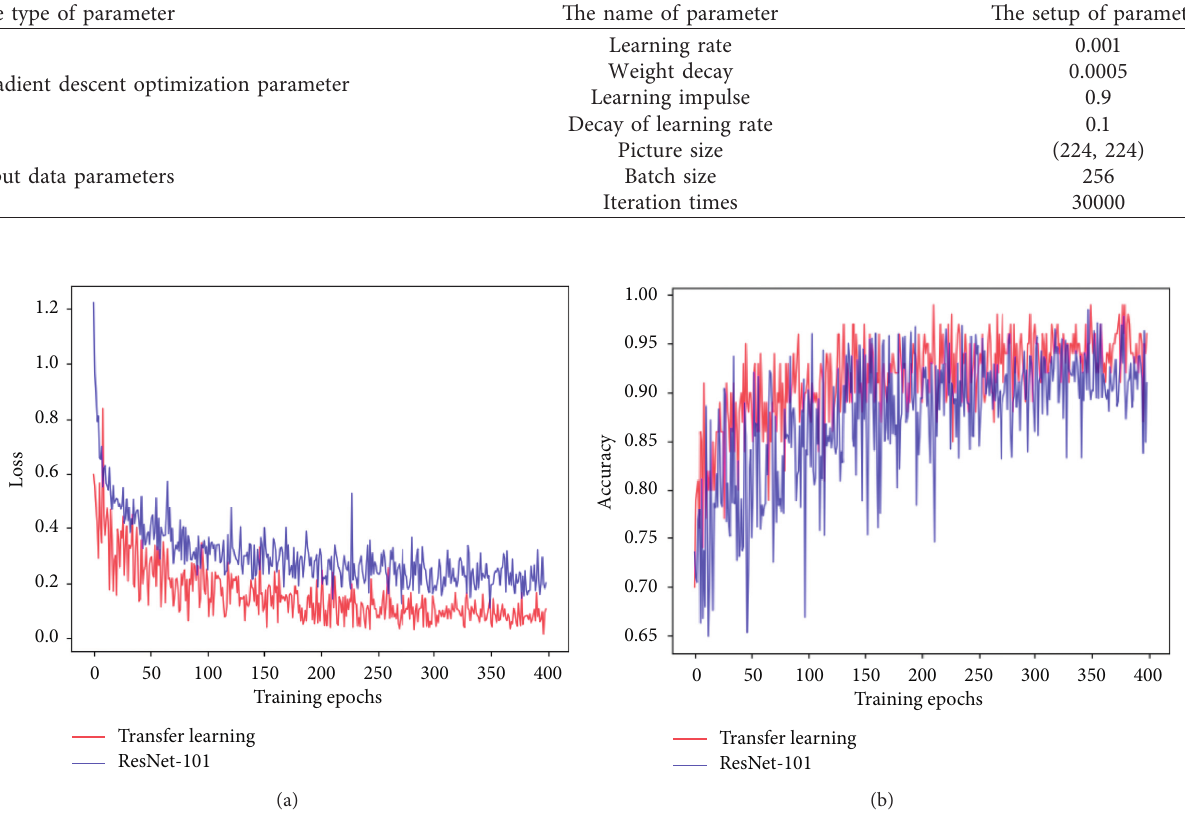
Table 4: The parameter setup of transfer learning.